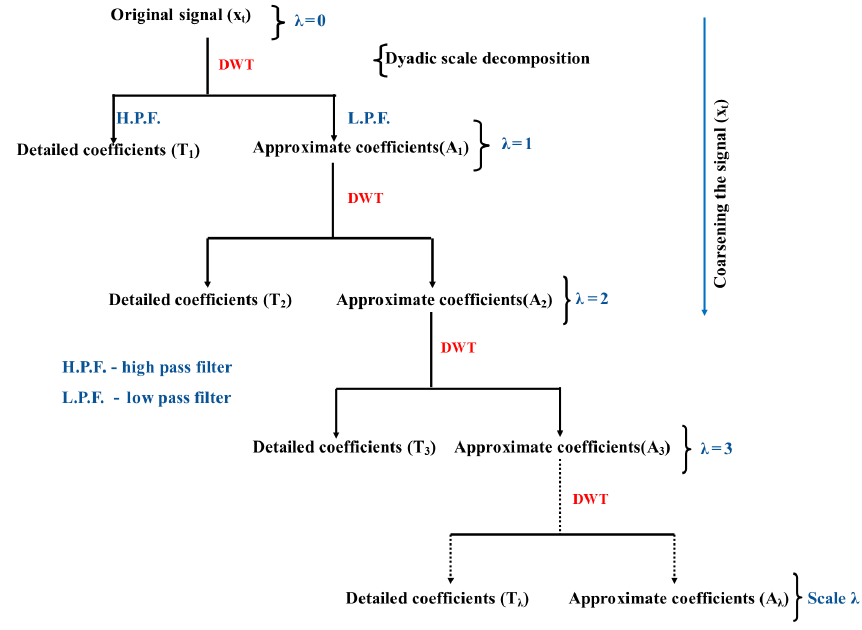
Figure 1. Schematic showing the decomposition tree for signal X t using